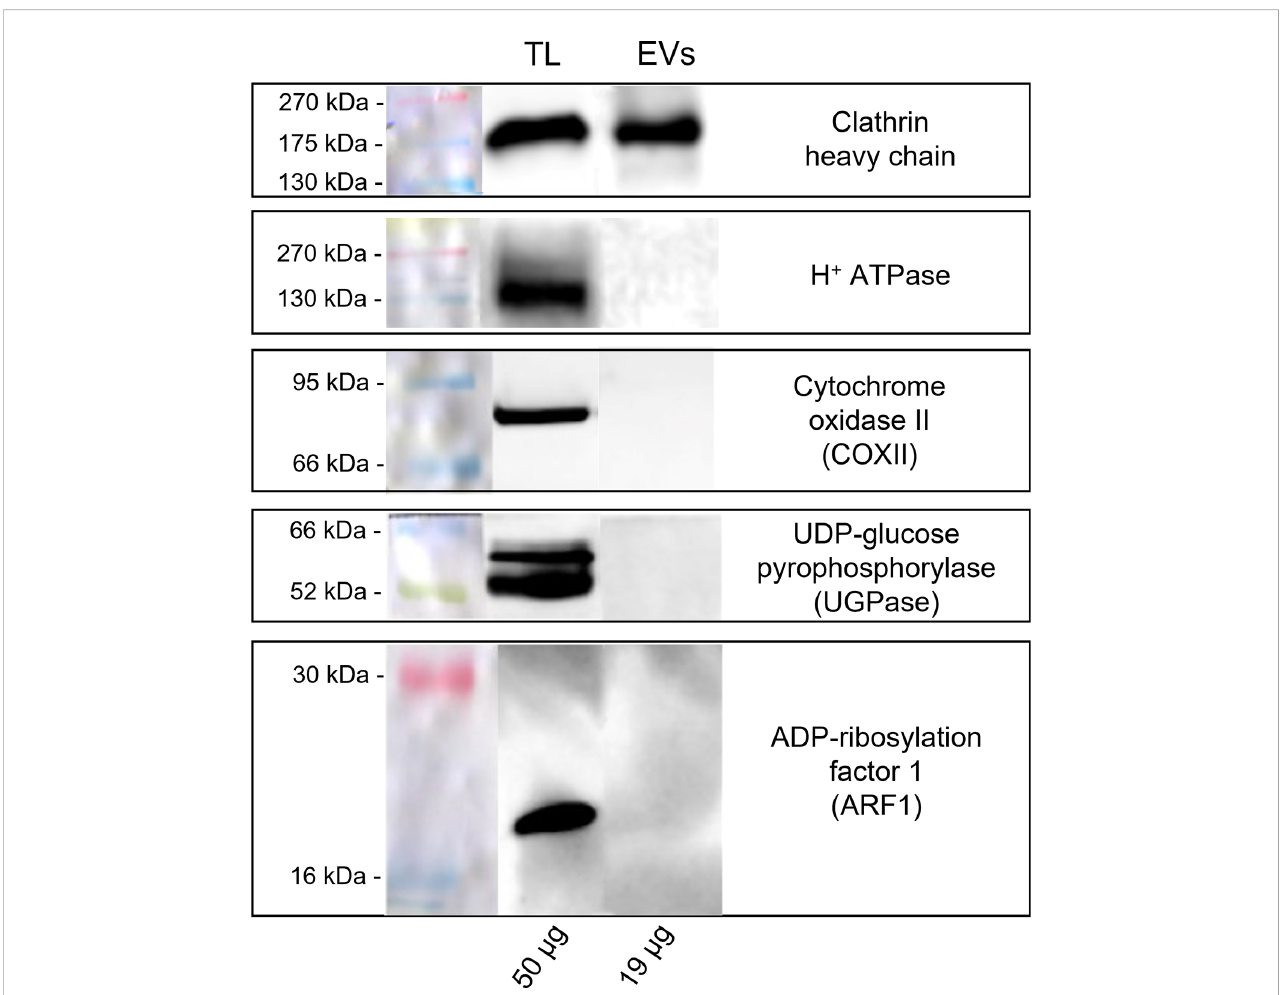
FIGURE 5 Western blot analysis of pollen total lysate (TL) and nanovesicles (EVs) fractions from germinated kiwi pollen (GKP). Samples were probed for the presence of molecular markers of different cell compartments with the following rabbit polyclonal antibodies: 1:2000 dilution of anti-clathrin heavy chain, 1:5000 dilution of anti-H+ATPase, 1:500 dilution of anti-COXII, 1:5000 dilution of anti-UGPase, 1:1000 dilution of anti-ARF1. The membranes were developed with ECL and read in chemiluminescence. On the left are reported the molecular weights of the pre-stained ladder, while on the bottom are reported the protein amounts loaded per lane.